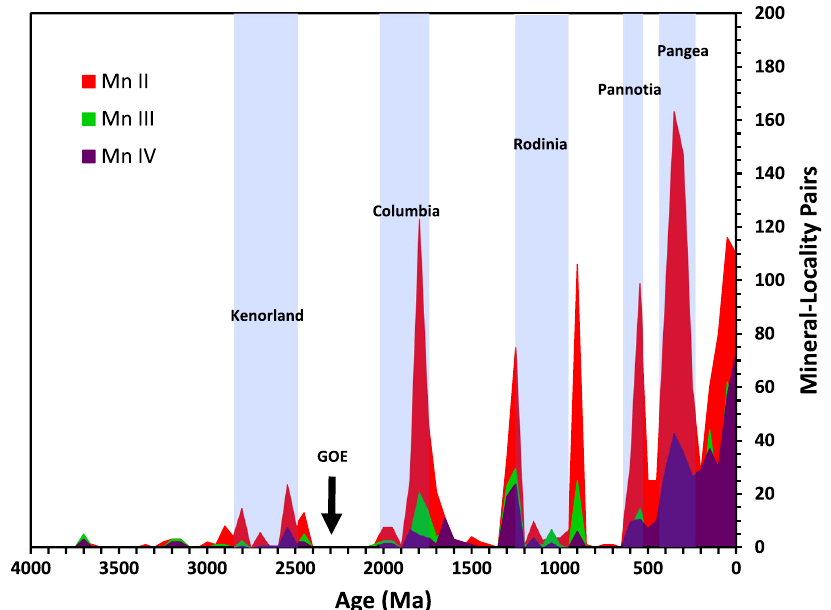
Fig. 1 Mn mineral occurrence histogram. A histogram showing the number of occurrences of mineral-locality pairs as a function of geologic time for all dated Mn-bearing mineral species, with data parsed into 50 million-year bins. Colors indicate oxidation state of Mn; Red = Mn(II), Green = Mn(III), Purple = Mn(IV). Blue bands represent intervals in which Earth ’ s major landmasses are thought to have consolidated into a